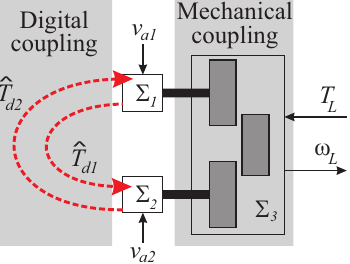
Figure 3. Interconnection topology of the EMSN depicting energy flow (solid edges) and information flow (dotted edges).